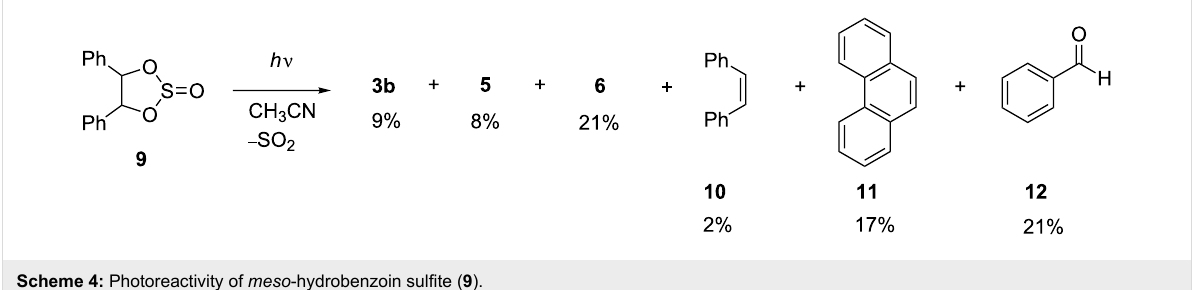
Scheme 4: Photoreactivity of meso -hydrobenzoin sulfite ( 9